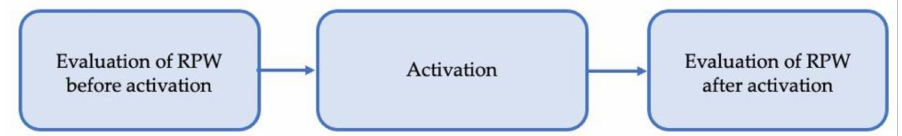
Figure 2. Each phase of the